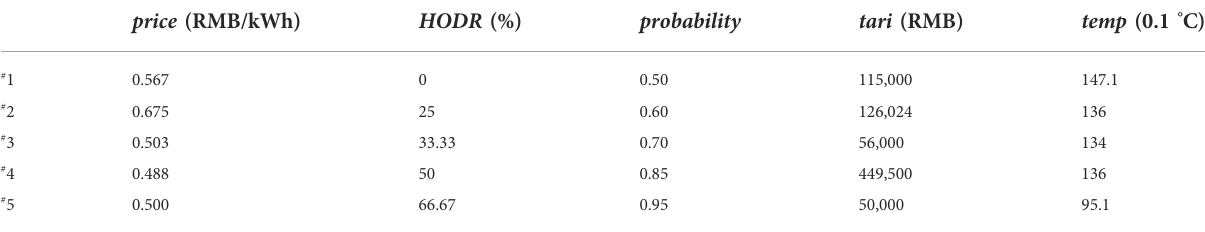
TABLE 5 Attribute values of the fi ve selected families.